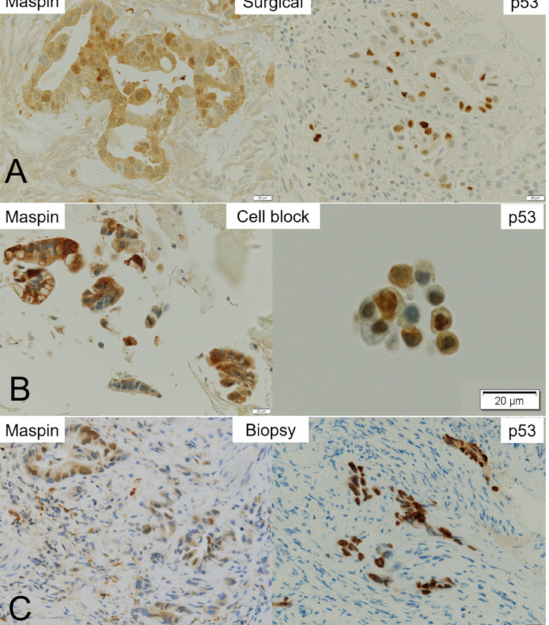
Figure 5. Representative maspin- and p53-immunohistochemistry in the surgical, cell block (CB), and biopsy specimens. Immunohistochemistry of maspin and p53 in ( A ) surgical, ( B ) CB, and ( C ) biopsy specimens. While maspin staining is found in almost all malignant cells in the surgical specimen, p53 staining is sparse in the nucleus of cancer cells. ( A ) Although nuclear positivity of maspin is clearly observed in adenocarcinoma cells, p53 expression is weak in their cytoplasm and sparse in the nucleus of cancer cells. ( B ) Maspin is strongly positive in the cytoplasm of adenocarcinoma cells in the CB specimen. On the contrary, the cancer cell nuclei are sparsely stained with p53. ( C ) Maspin staining is positive in the cytoplasm and/or nuclei of adenocarcinoma cells in a biopsy specimen. p53 staining is positive in the nuclei of cancer cells. Table 5. Comparison of the maspin/p53-immunohistochemistry (IHC) in each specimen.